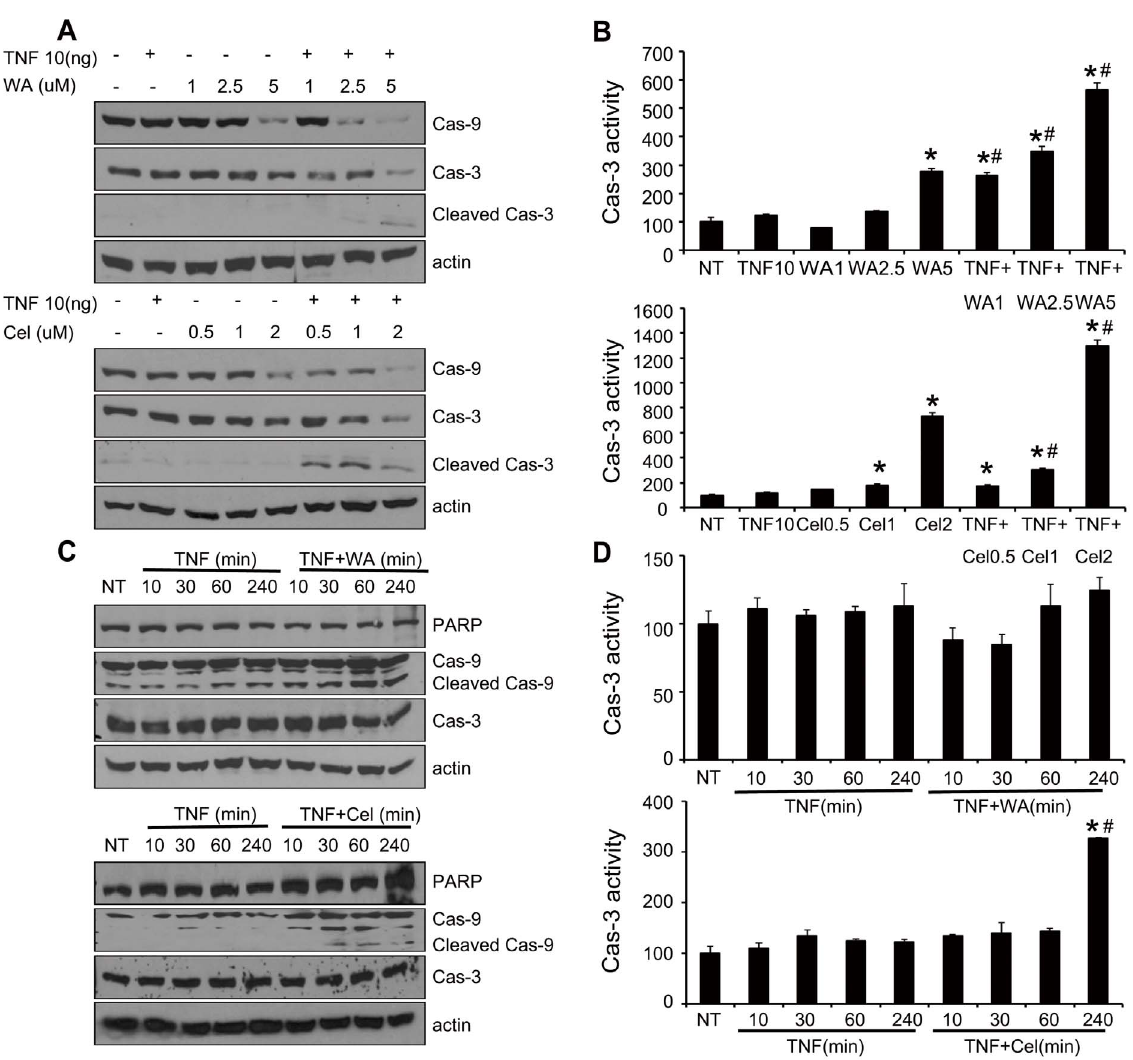
Figure 3. Dose effects of TNF- a plus WA or Cel on caspase-3 and -9 in MDA-MB-231 cells. (A) Concentration dependent effect of WA and TNF- a or Cel and TNF- a combination on caspase-3 and -9 expression. Cells were treated with the indicated concentrations of WA (upper) or Cel (lower) with or without TNF- a (10 ng/ml) for 24 hours, followed by detection of caspase-3 and -9 by Western blotting. (B) Dose effect of WA and TNF- a or Cel and TNF- a combination on caspase-3 activity. Cells were treated with the indicated concentrations of WA (upper) or Cel (lower) with or without TNF- a (10 ng/ml) for 24 hours, followed by detection of caspase-3 activity by adding specific substrate Ac-Asp-Glu-Val-Asp-AMC. (C) Kinetic effects of WA and TNF- a or Cel and TNF- a combination on caspase-3 and -9. Cells were treated with TNF- a (10 ng/ml) or TNF- a (10 ng/ml) plus WA (1 m M) (upper), or TNF- a (10 ng/ml) plus Cel (1 m M) (lower) for the indicated times, followed by detection of caspase-3 and -9 by Western blotting. (D) Kinetic effect of TNF- a plus WA or TNF- a plus Cel on caspase-3 activity. Cells were treated with TNF- a (10 ng/ml) or TNF- a (10 ng/ml) plus WA (1 m M) (upper), or TNF- a (10 ng/ml) plus Cel (1 m M) (lower) for the indicated times, followed by detection of caspase-3 activity via adding the specific substrate Ac-Asp-Glu-Val-Asp-AMC. Data are shown as mean ¡ SD of three experiments. (* P , 0.05, as compared with the untreated control. # P , 0.05, WA/Cel treated versus WA/Cel + TNF- a